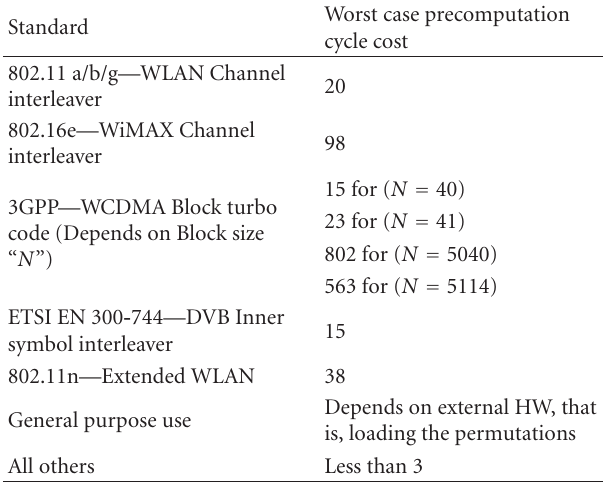
Table 3: Precomputation cycle cost for di ff erent standards. Table 4: Summary of implementation